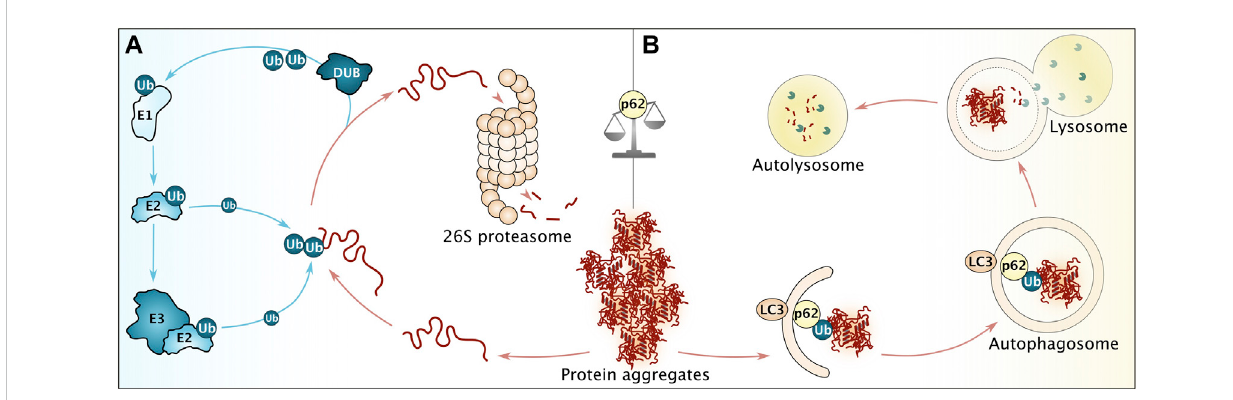
FIGURE 4 Overview of major cellular degradation pathways. (A) Before degradation via the ubiquitin-proteasome system (UPS), aggregated proteins require disaggregation, followed by decoration with poly-ubiquitin (Ub) moieties. This reaction is facilitated by ubiquitin-activating enzymes (E1), ubiquitin- conjugating enzymes (E2) and ubiquitin ligases (E3). Prior to degradation, ubiquitin moieties are removed by deubiquitinating enzymes (DUB). (B) Persistent aggregates are subjected towards autophagosomal degradation. To that end, p62 recognizing ubiquitin moieties facilitates the interaction of aggregates with LC3 on the growing autophagosome membrane. Please note that more proteins are involved to ensure ef fi cient autophagy. After membrane closure, the autophagosome fuses with lysosomes in metazoan, leading to degradation of proteinaceous content (in autolysosomes). p62 (among other factors) serves to balance degradation via UPS and